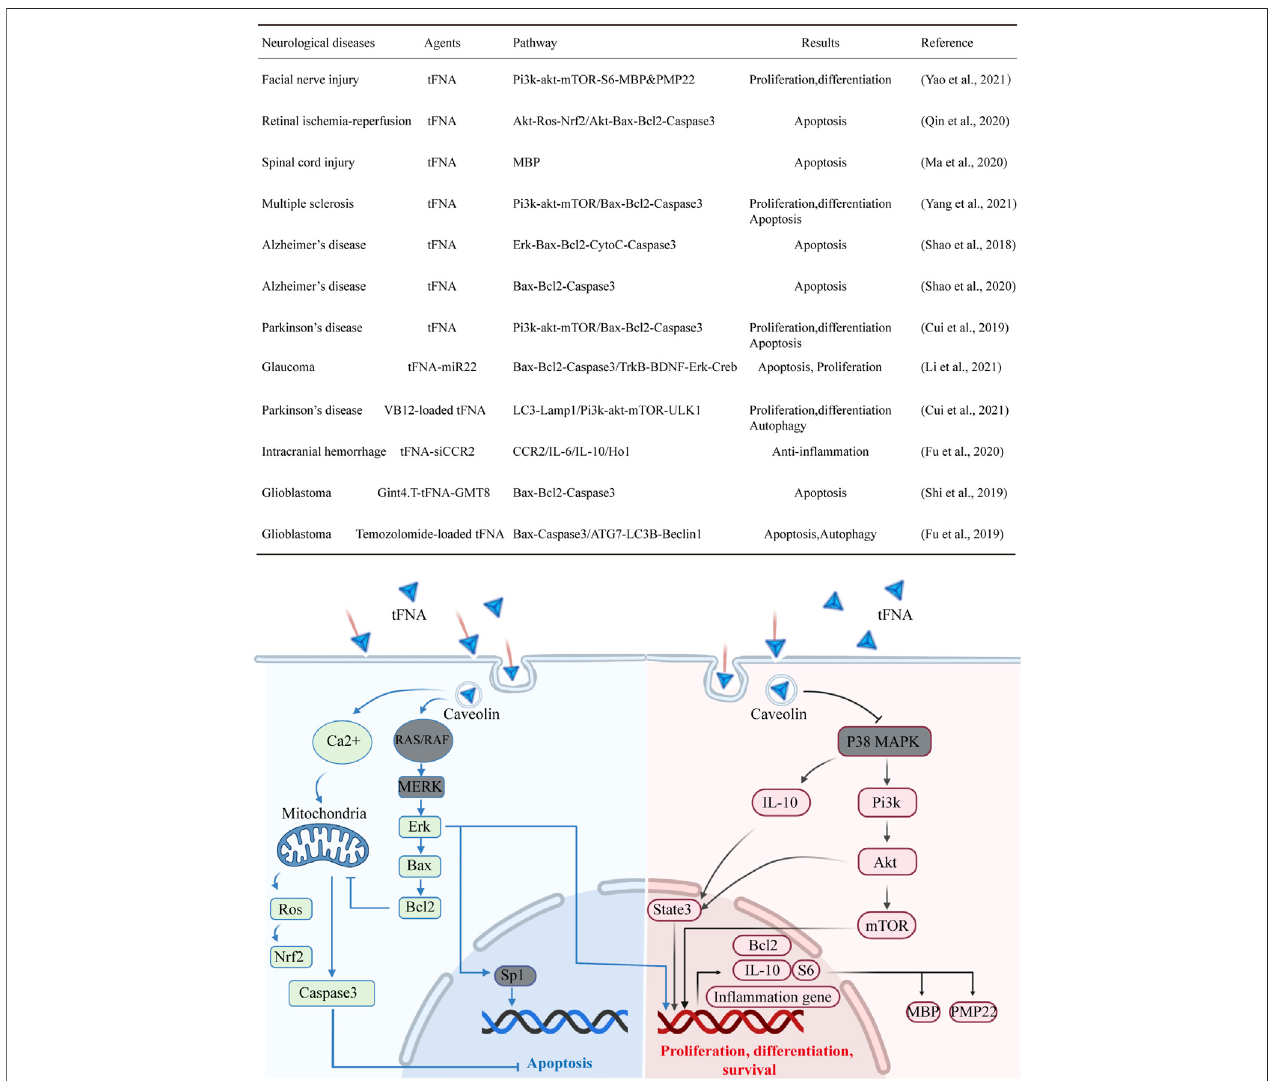
FIGURE 3 | The possible mechanisms of tFNA-based nanomaterials used in NDs.